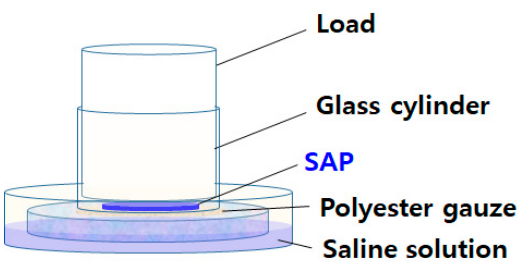
Figure 1. Scheme of the absorbency under load tester.